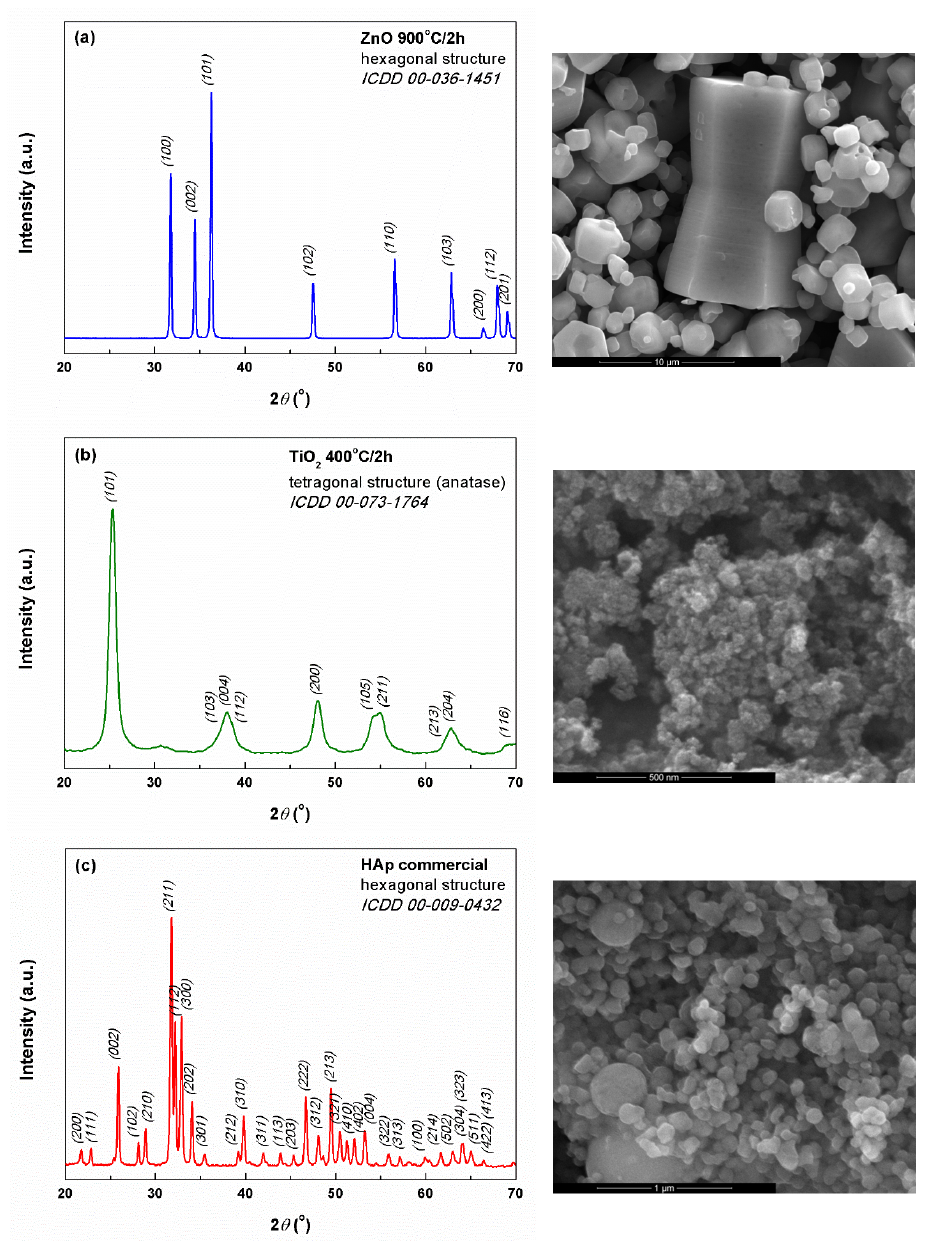
Figure 1. XRD patterns (left) and SEM images (right) of the mineral powders: ( a ) ZnO, ( b ) TiO 2 , and ( c ) HAp.